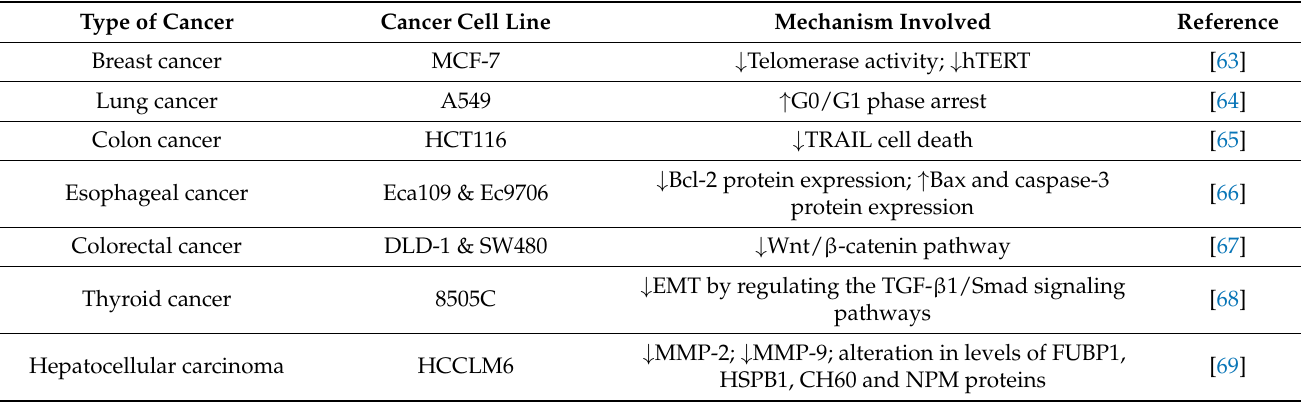
Table 2. Cancer-related molecular targets of EGCG (in vitro studies).